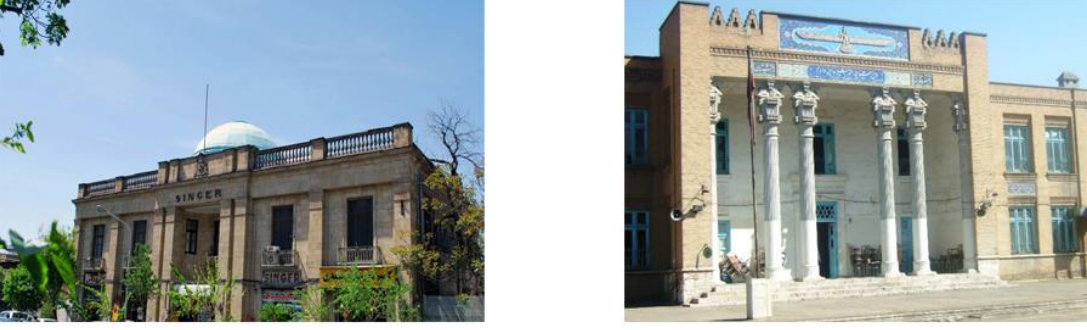
Figure 6 The Singer building by Nikolai Markov Figure 7 Anooshirvan Dadgar High School by Nikolai